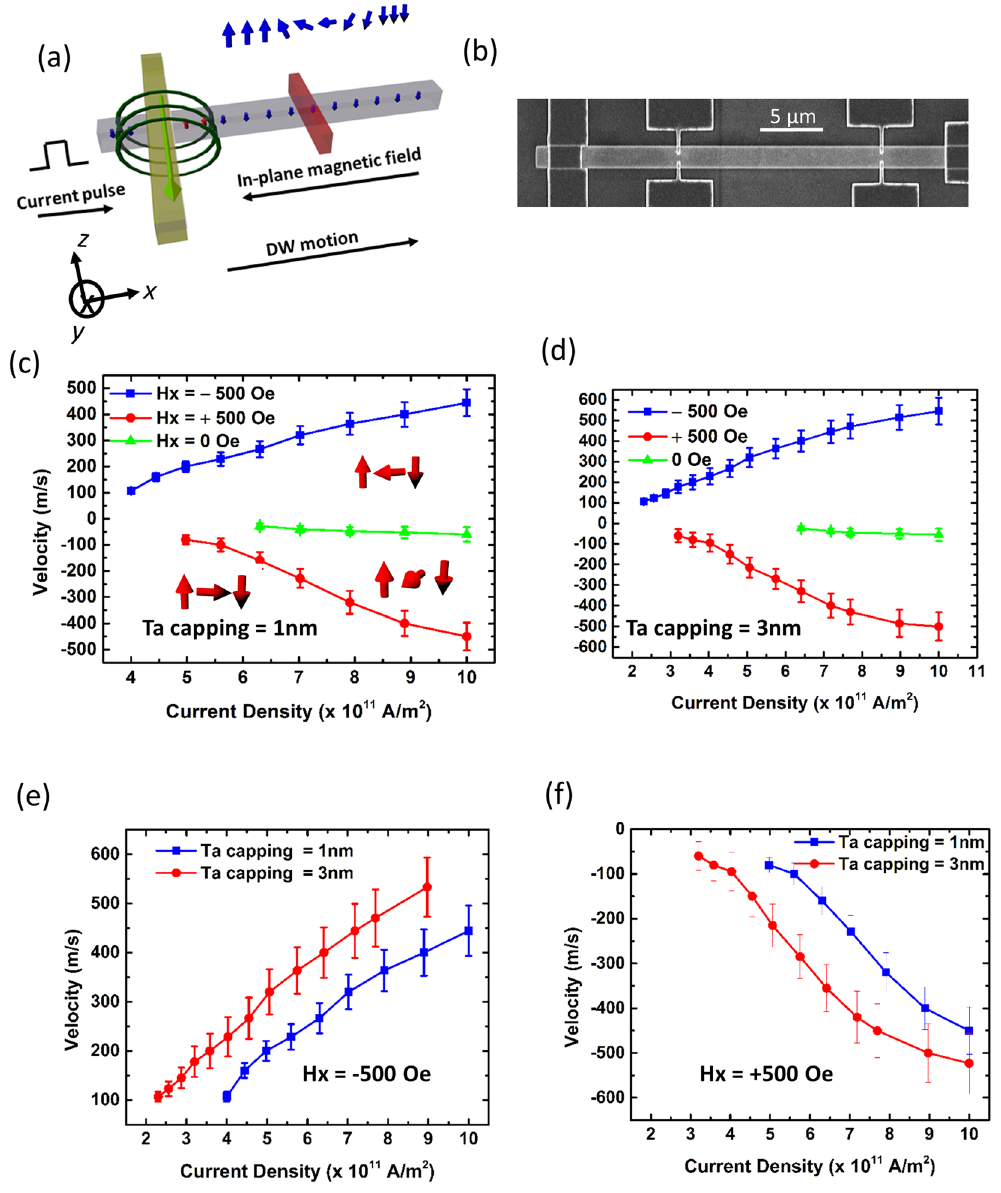
Figure 1. ( a ) Schematic depicting the setup for domain wall (DW) injection and driving measurement. ( b ) SEM image of the wire with non-magnetic Hall probes for DW detection. DW velocity versus current density under a constant in-plane magnetic field along + x and − x -directions for Ta capping with thickness ( c ) 1 nm, and ( d ) 3 nm. Comparison of DW velocity for Ta capping thicknesses 1 nm and 3 nm; magnetic field was applied along the ( e ) − x -direction, and ( f ) + x